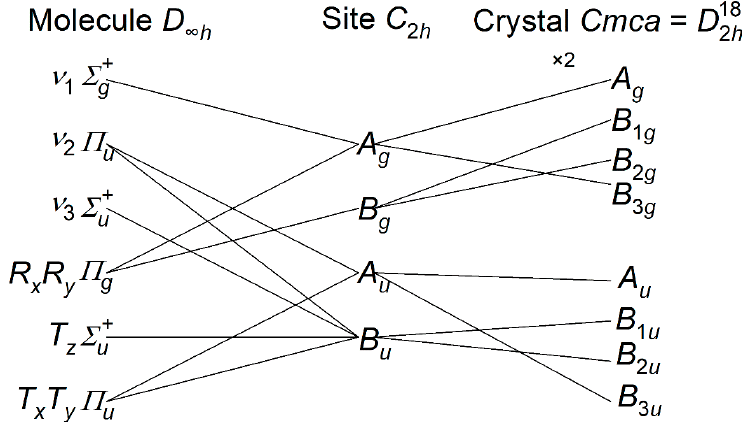
Figure 2. Correlation table for carbon disulfide in the solid state. R = libration, T = translation.